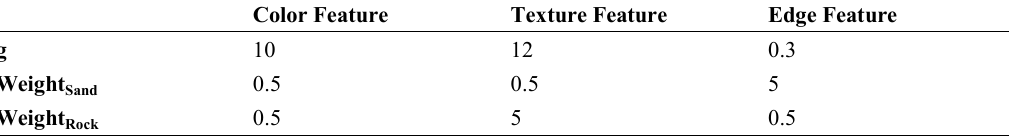
Table 3. Parameter Setting for the SVM classifier: g and weight (cost of